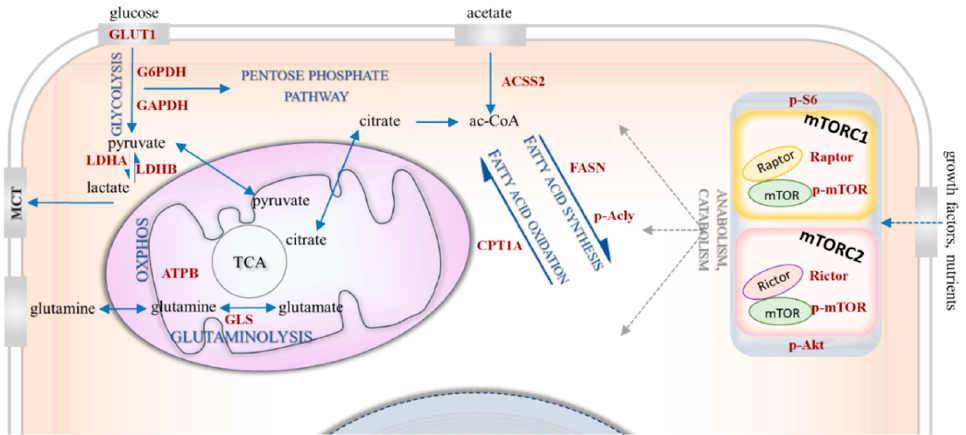
Figure 1. Bioenergetic mechanisms in metabolic rewiring. The simplified figure shows the investigated bioenergetic pathways with the metabolic enzymes and proteins of interest. The mTOR-related proteins include p-S6, p-(Ser473)-Akt (p-Akt), p-mTOR, Raptor, Rictor. The metabolic enzymes/proteins include GLUT1 (glucose transporter 1), GAPDH (glyceraldehyde 3-phosphate dehydrogenase), G6PDH (glucose-6-phosphate dehydrogenase), LDHA (lactate dehydrogenase A) and LDHB (lactate dehydrogenase B) involved in glycolysis; GLS (glutaminase) involved in glutaminolysis; ACSS2 (acyl-coA synthetase short-chain family member 2) involved in acetate consumption; and FASN (fatty acid synthase), p-Acly (phospho-ATP-citrate lyase) and CPT1A (carnitine palmitoyltransferase 1A) involved lipid metabolism.